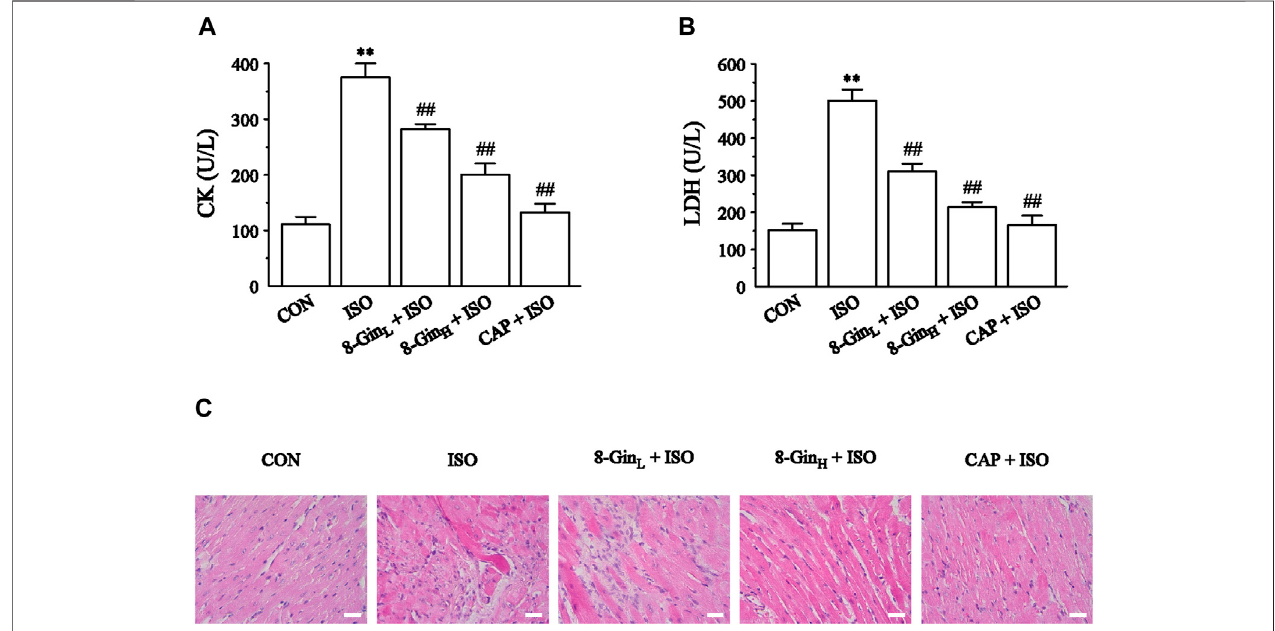
FIGURE 3 | Effects of 8-Gin on cardiac biomarkers and histopathology. (A, B) The concentration of mice serum CK and LDH, respectively. Data are shown as the mean ± SEM, n (cid:1) 6. ** p < 0.01 vs. the CON group; ## p < 0.01 vs. the ISO group. (C) Representative H&E staining histologic slices in fi ve groups of CON, ISO, 8-Gin L + ISO, 8-Gin H + ISO, and CAP + ISO (magni fi cation × 400, scale bar (cid:1) 50 μ m).